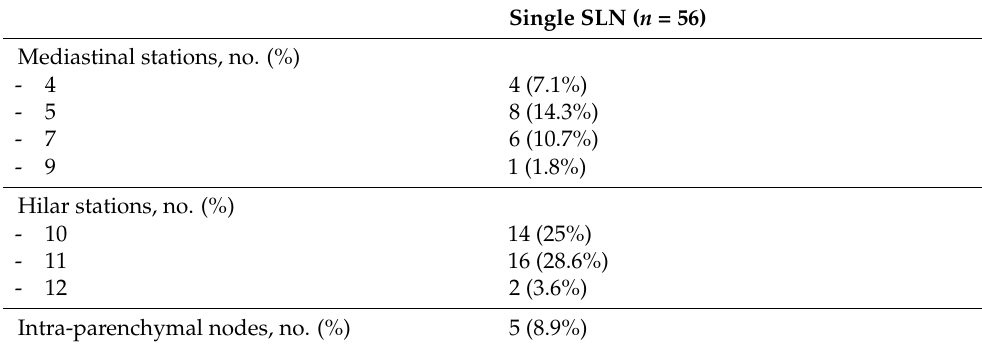
Table 3. Sentinel lymph node locations.